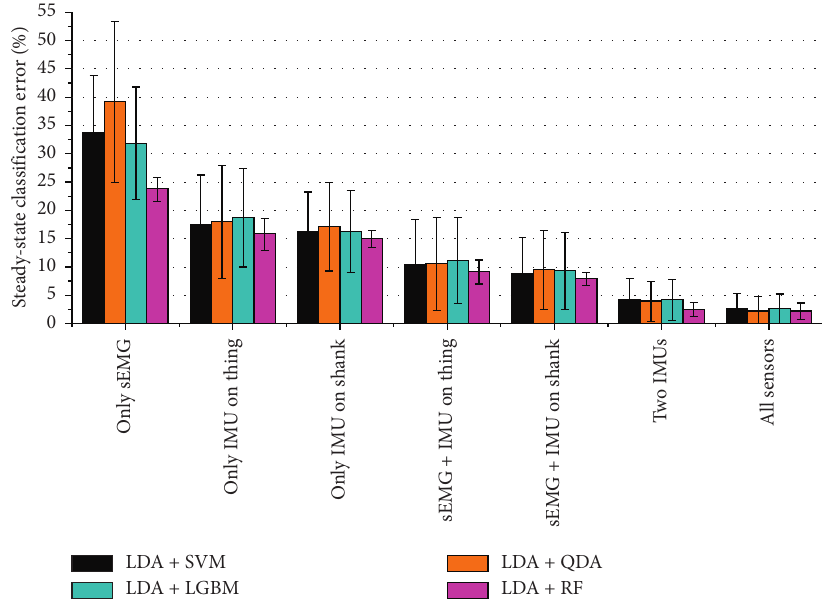
Figure 5: Contributions of different sensors and sensor combinations. Error bars represent ±